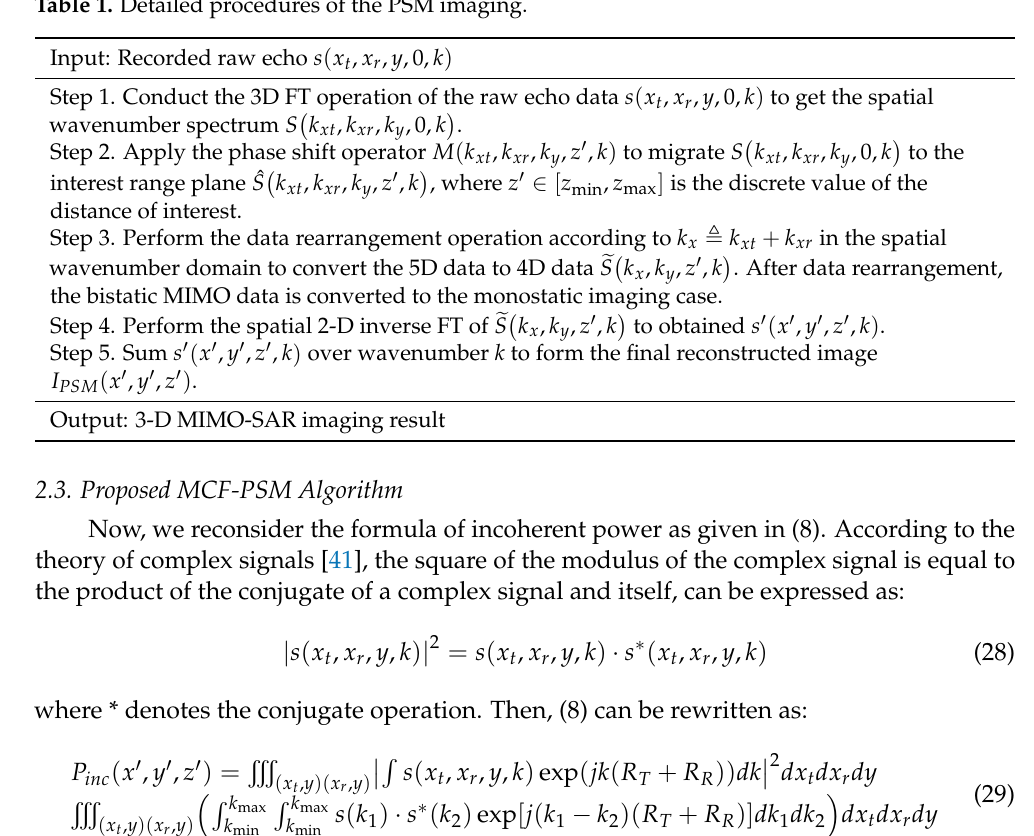
Figure 3. The flowchart of MIMO-SAR PSM imaging. Table 1. Detailed procedures of the PSM